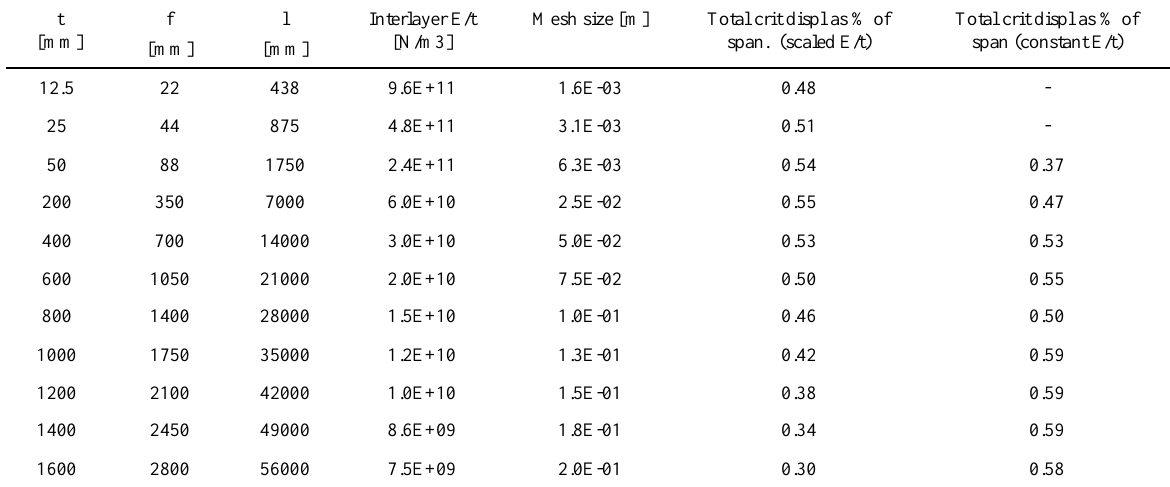
Table 6 Results scaling with constant asymmetric